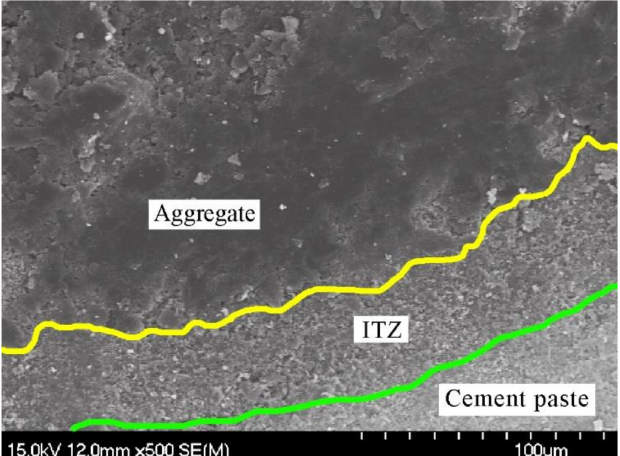
Figure 2. SEM image of ITZ [6]. (Reproduced with permission from Wang et al, Construction and Building Materials; published by Elsevier,